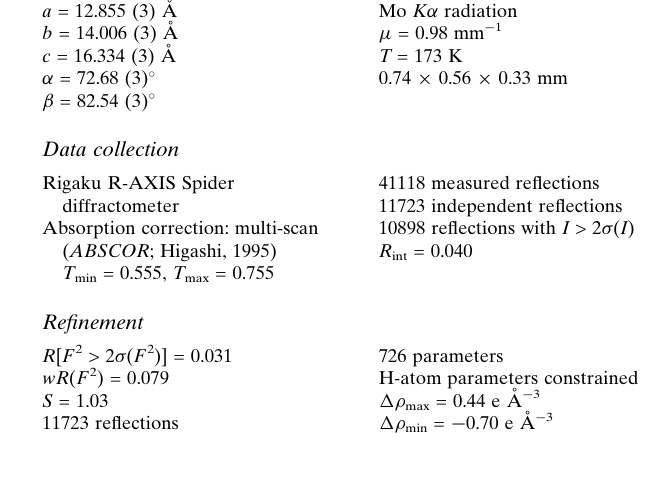
Rigaku R-AXIS Spider diffractometer